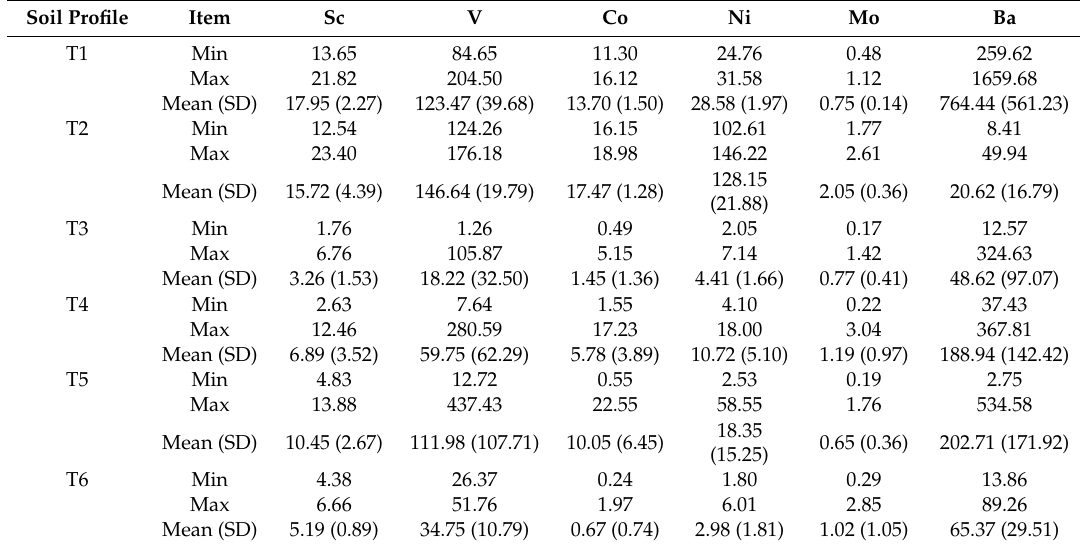
Figure 2. Vertical distributions of heavy metals, including Sc ( a ), V ( b ), Co ( c ), Ni ( d ), Mo ( e ) and Ba ( f ). (Some data were omitted because of their small variation ranges). Table 2. Statistical results for heavy metal contents (mg kg − 1 ) of soil samples from six soil